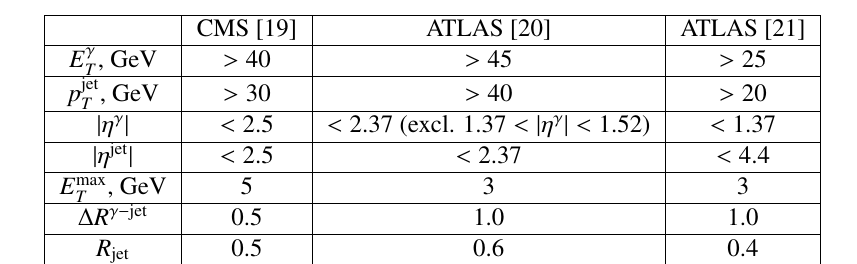
Table 1. Basic parameters, used for